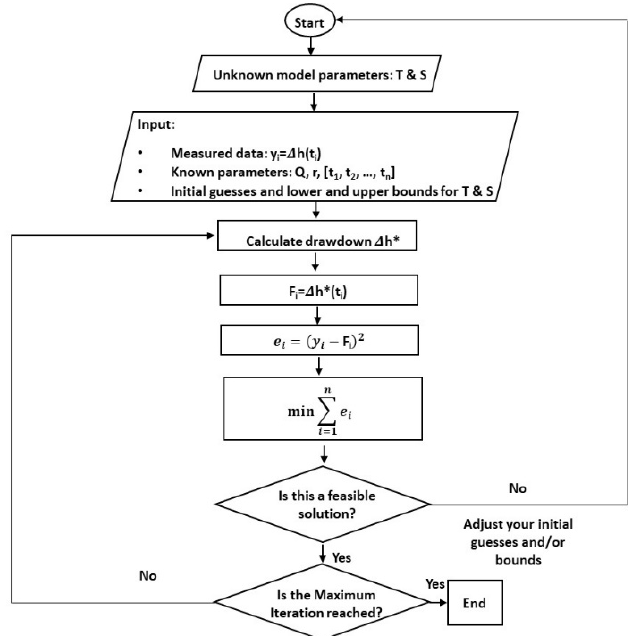
Figure 1. Flowchart describing for fitting procedure. The scipy.optimize.curve_fit function available in the Python library offers three possi- ble nonlinear solvers: the Levenberg–Marquardt (LM), Trust-Region Reflective (TR), and Dog Box (DB) methods. The LM method is a default algorithm for solving nonlinear